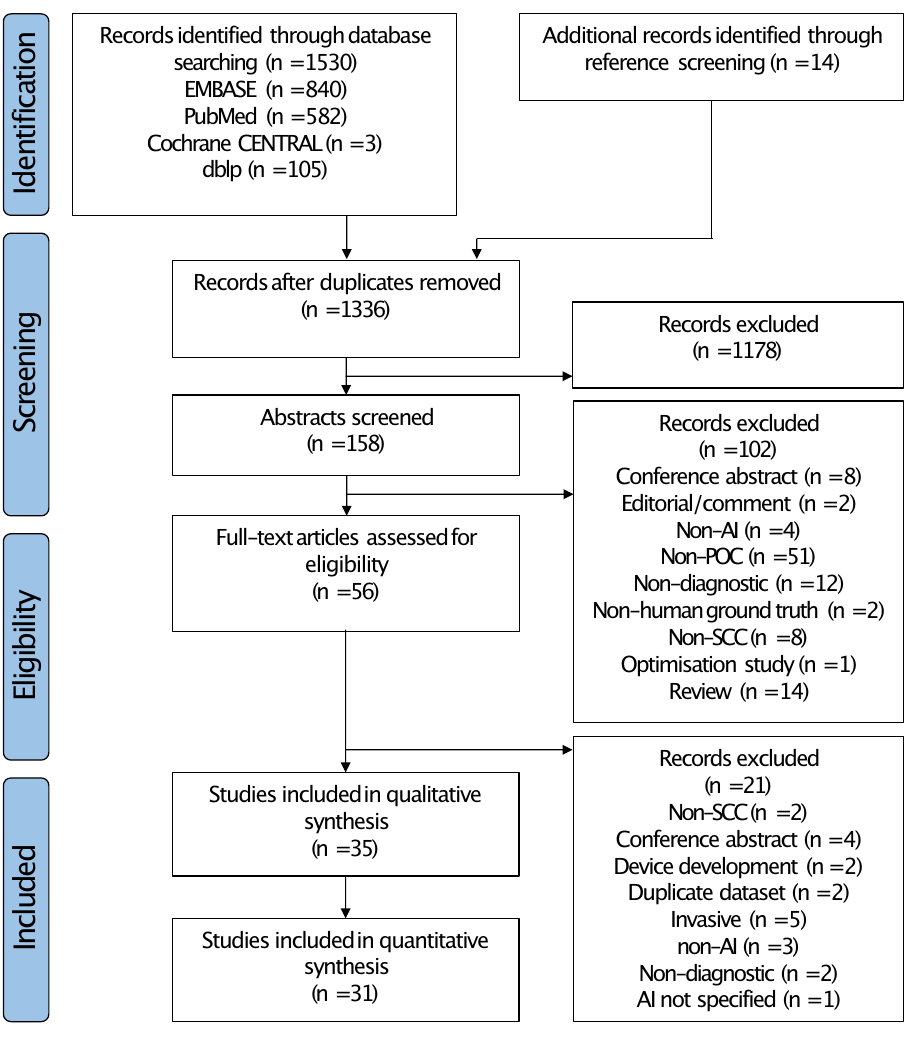
Figure 1. PRISMA flow diagram for study